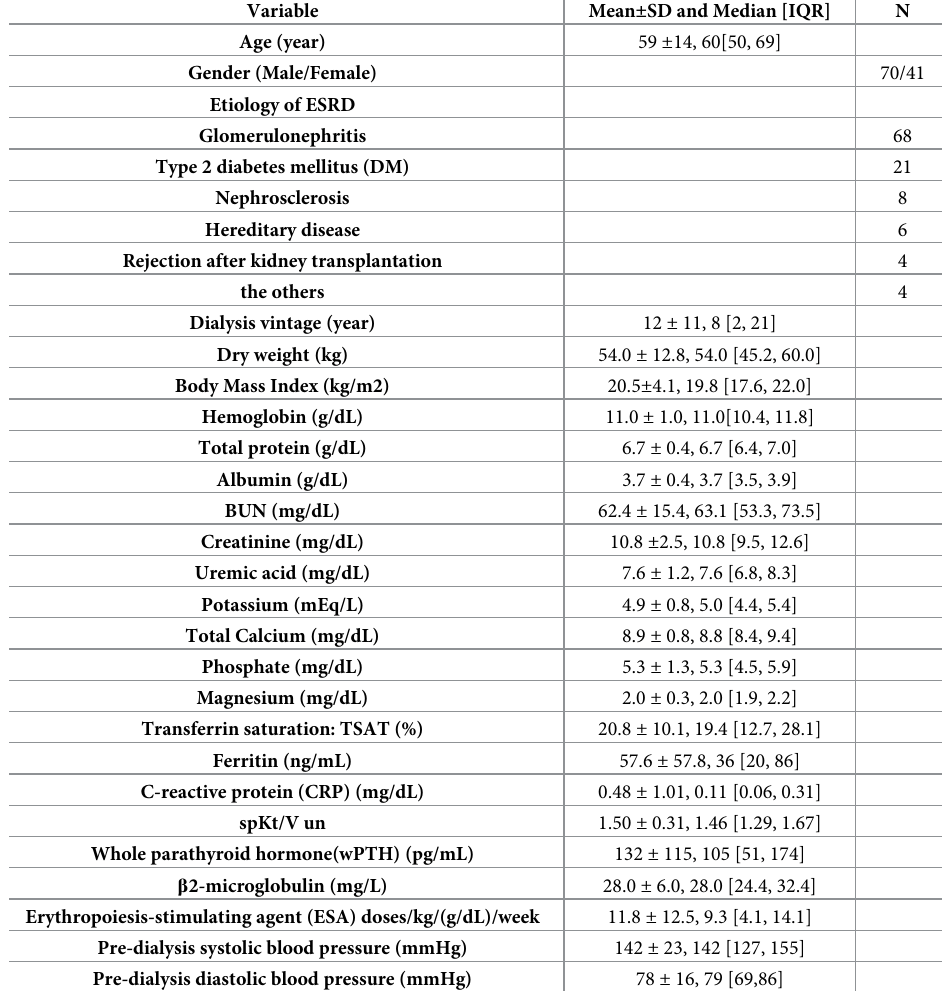
Table 1. Baseline characteristics of enrolled patients (n = 111).